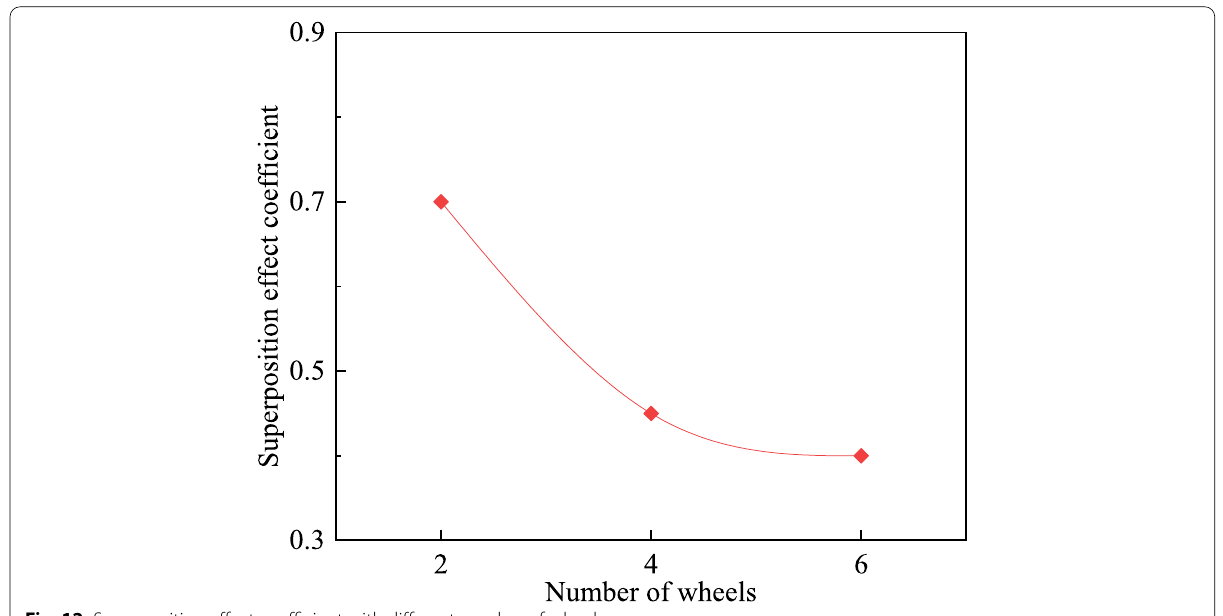
Fig. 12 Superposition effect coefficient with different number of wheels